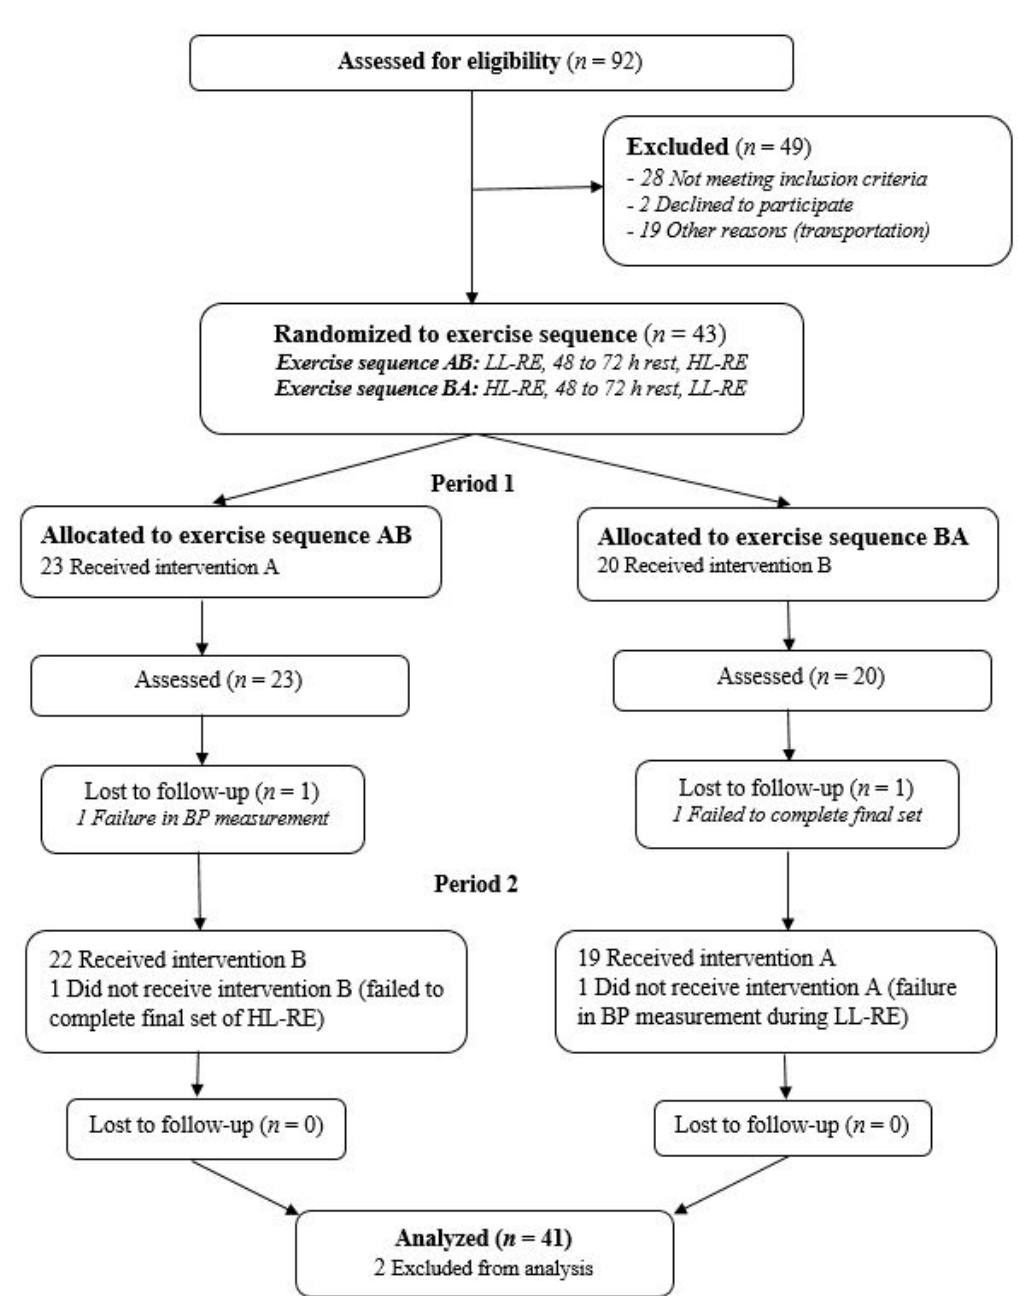
Figure 1. CONSORT flow chart of the study. LL, low load; HL, high load; RE, resistance exercise; BP, blood pressure.